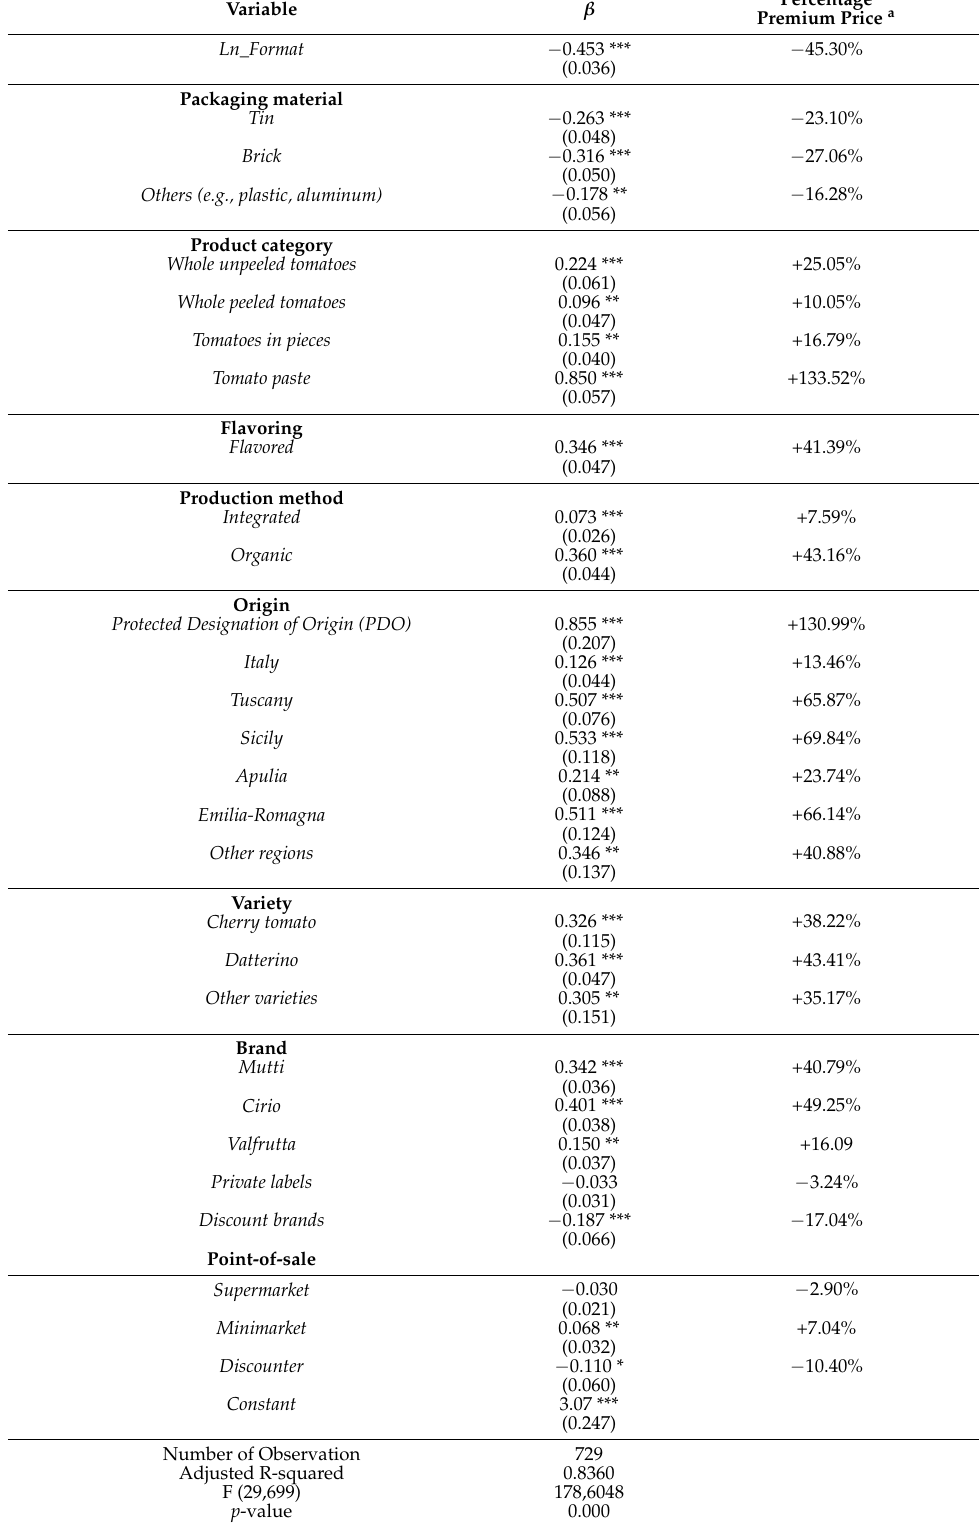
Table 3. Estimated parameters and percentage premium